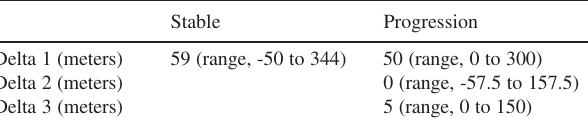
Table 2 - Variation in the change in maximum walking distance (MWD) during follow-up Stable